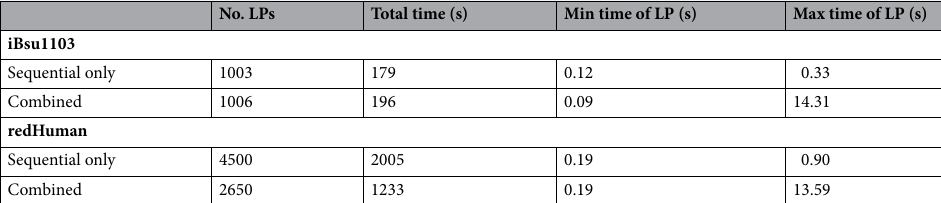
No. LPs Total time (s) Min time of LP